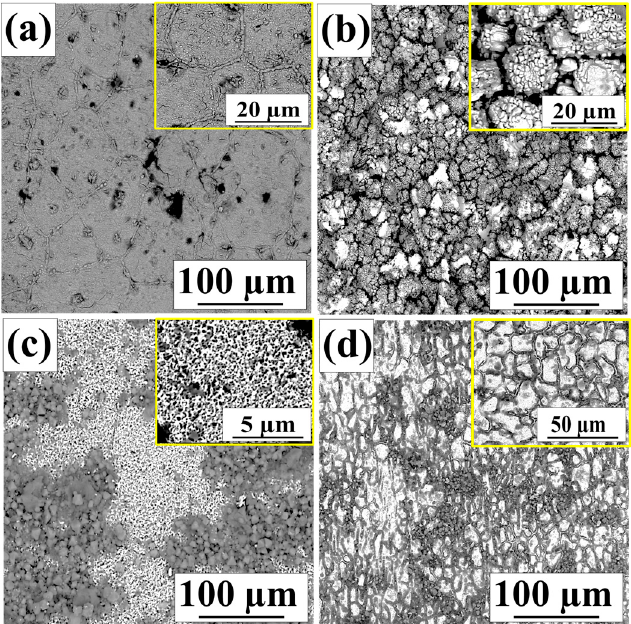
Figure 5. SEM image of the surface after electrochemical test at 650 °C for: ( a ) HfTaTiVZr, ( b ) Ta ‐ TiVWZr, ( c ) IN718, and ( d ) SS316; the insets in figures ( a ) through ( d ) show a zoomed ‐ in view of the corroded surface indicating grain boundary corrosion for HfTaTiVZr and SS316 in contrast to pitting corrosion for IN718 and selective corrosion of inter ‐ dendritic region in TaTiVWZr.